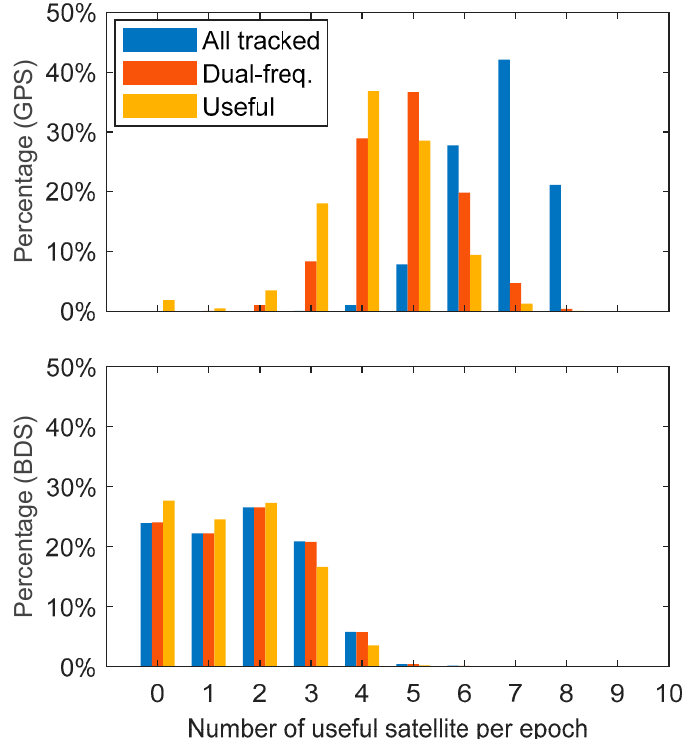
Figure 4. Average percentage of all tracked, dual-frequency and useful satellites per epoch of one-month data for GPS ( top panel ) and BDS ( bottom panel ). Blue bars represent the percentage of all tracked satellites; red bars indicate the percentage of satellites that have been tracked for dual-frequency data; yellow bars represent the percentage of useful satellites.